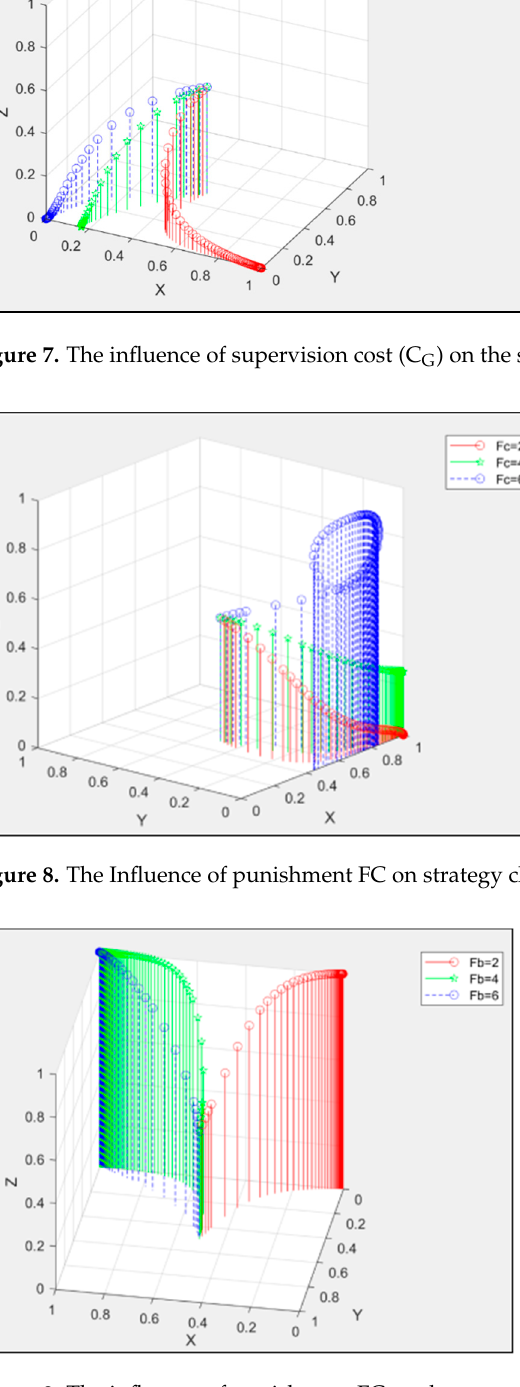
Figure 10. The influence of subsidizing P B on the strategic choice of all parties.